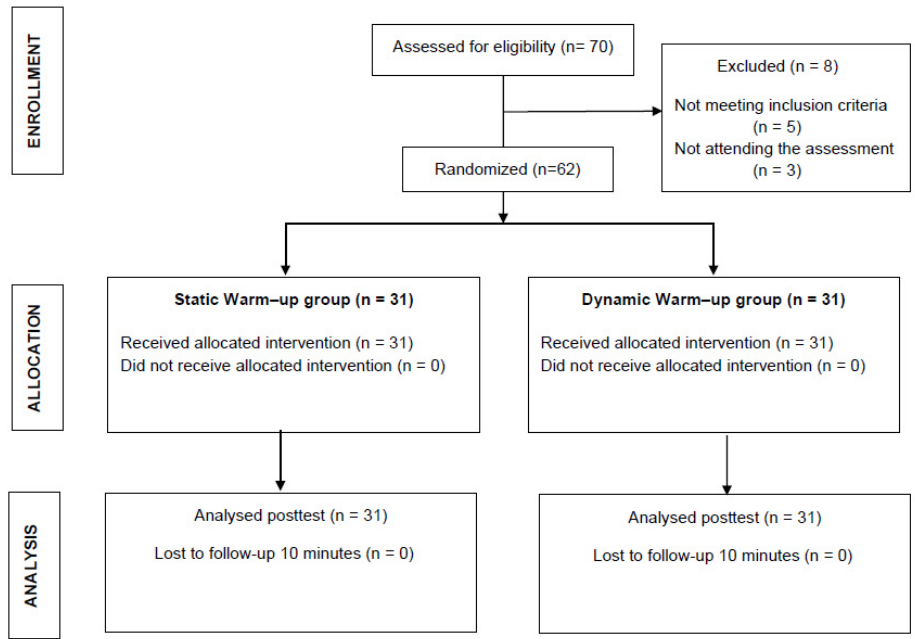
Figure 1. Flow diagram of participant recruitment.